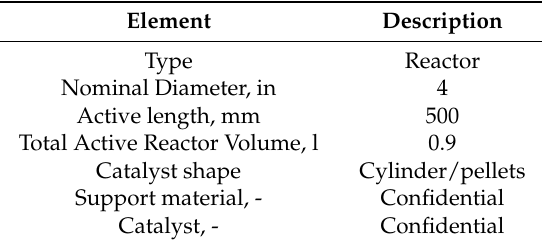
Table 7. Main characteristics of the CPO reactor.